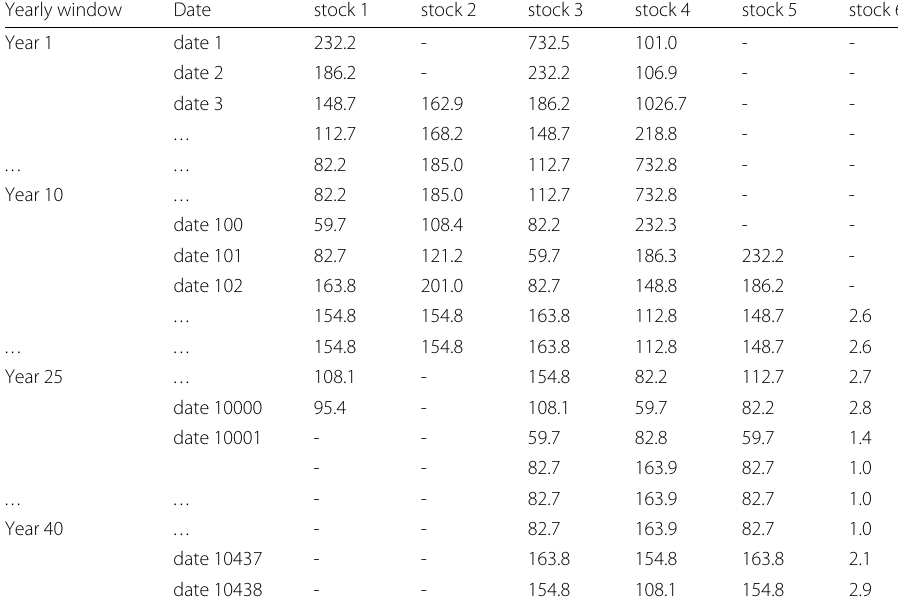
Table 1 Structures for three groups of collected data Yearly